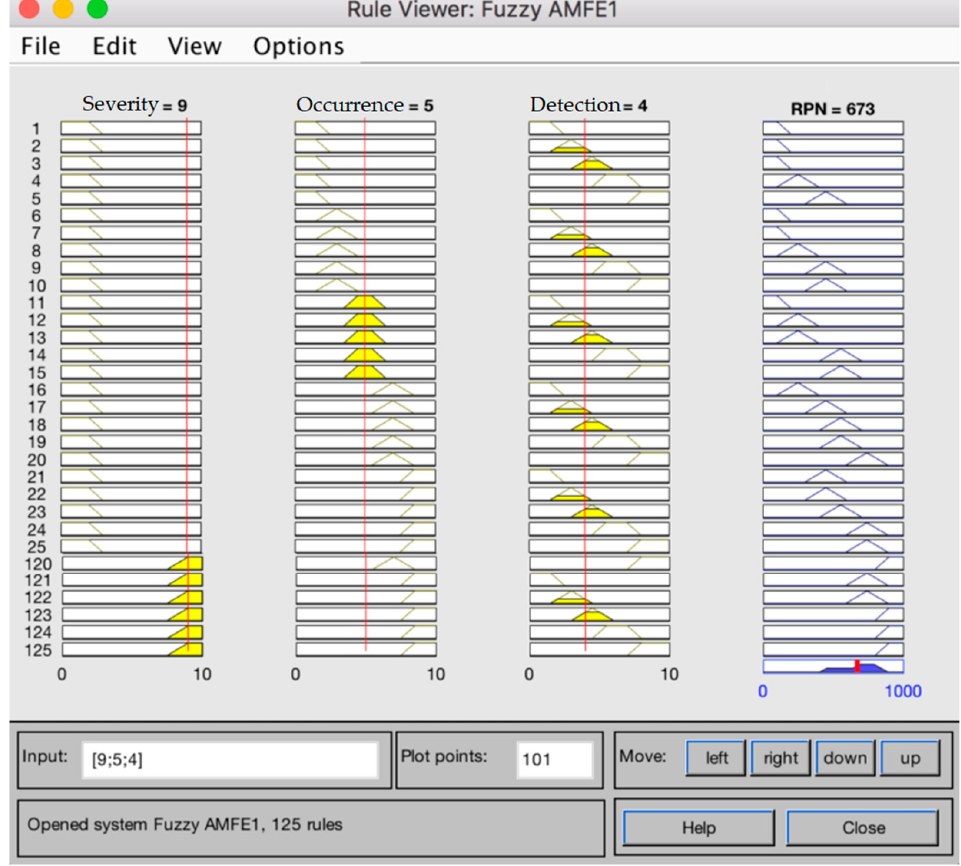
Figure 6. An example of the rule viewer for failure mode “Conical winding”.